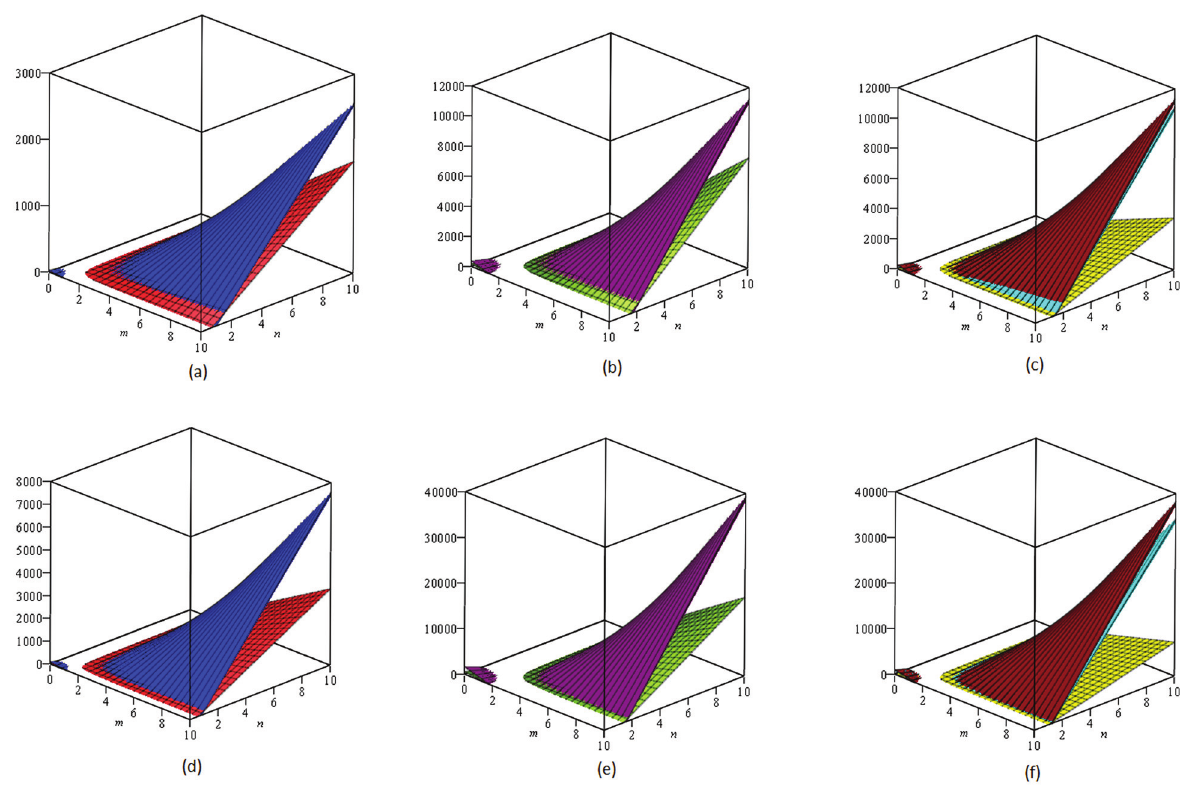
FIGURE 8: (a) 3D plot of M purple graphs, (c) 3D plot of ZC ( ),